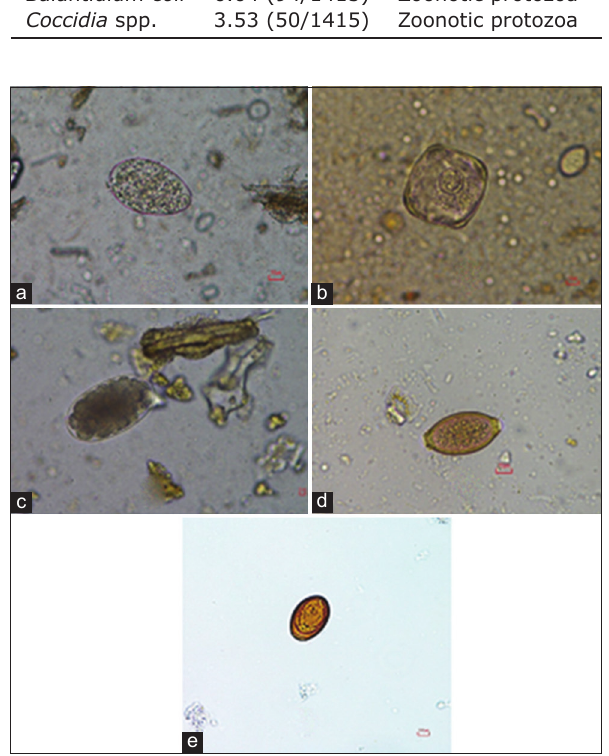
Figure-1: Helminth eggs present in fighting bull samples. (a) Rumen fluke; (b) Moniezia spp.; (c) Strongyle spp.; (d) Trichuris spp.; and (e) Eurytrema